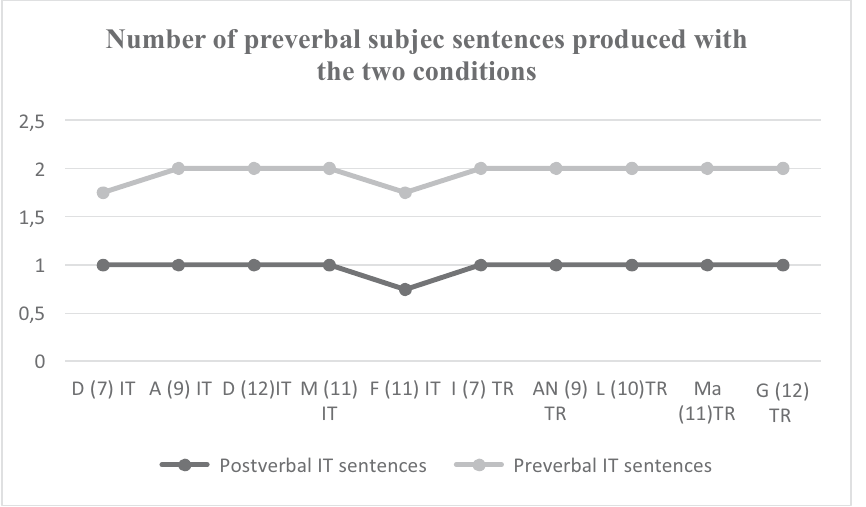
Figure 4: The number of postverbal subject sentences produced when the Italian sentence contained either a postverbal or a preverbal subject. Each child is indicated by an abbreviated name, age in parentheses, and school curriculum ( TR for Turkish curriculum school and IT for Italian curriculum ) . The graph clearly shows how children produced constantly pragmatically felicitous sentences in